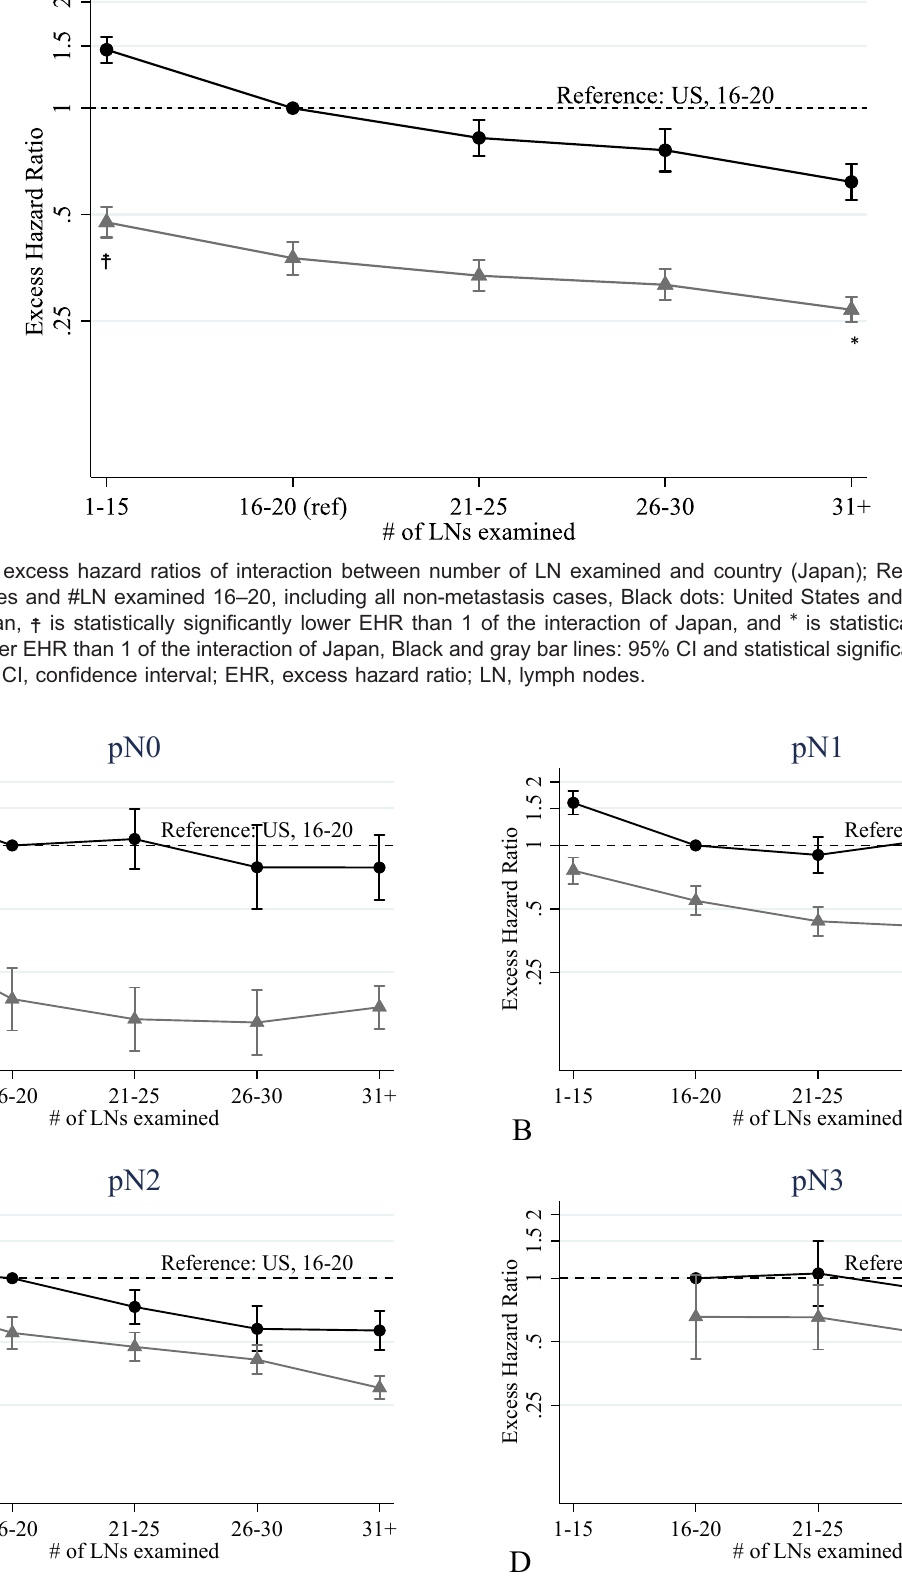
246 j J Epidemiol